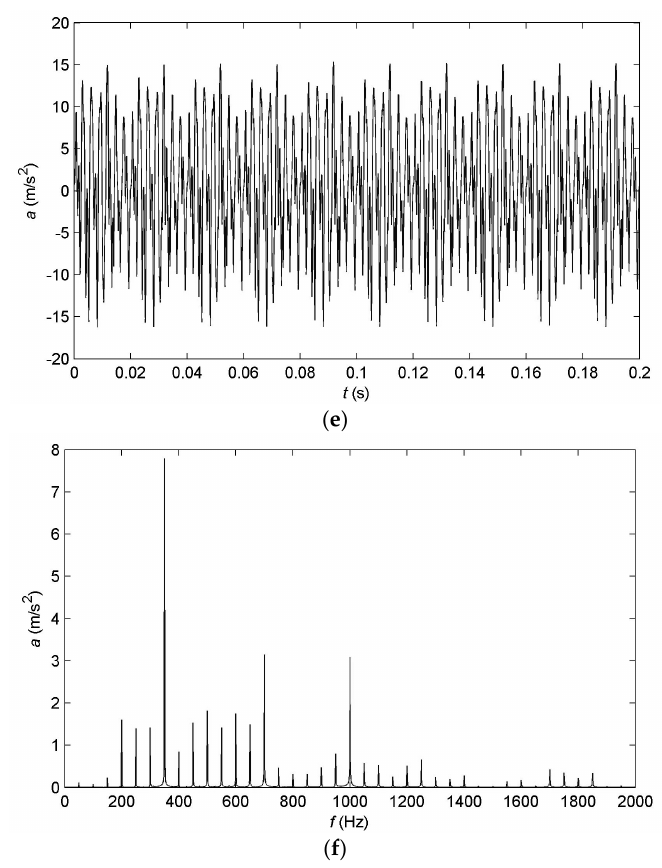
Figure 4. Transformer vibration with DC bias: ( a ) Time-domain waveform of point 1; ( b ) Frequency spectrum distribution of point 1; ( c ) Time-domain waveform of point 2; ( d ) Frequency spectrum distribution of point 2; ( e ) Time-domain waveform of point 3; ( f ) Frequency spectrum distribution of point 3.